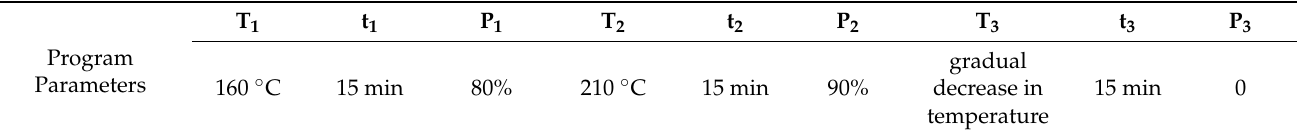
Table 1. Program parameters (T—temperature, t—time, P—power) from the acidic digestion with microwave system MWS-2, realized in three steps.